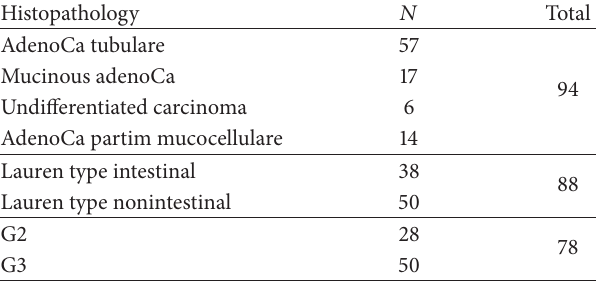
Table 1: Histopathology of diagnosed gastric